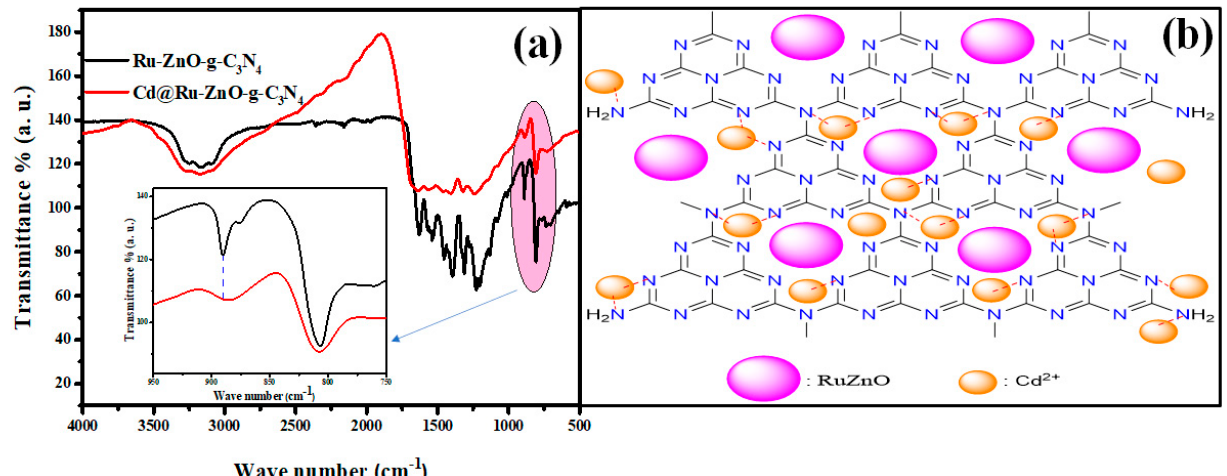
Figure 10. FTIR spectra of ( a ) before and after Cd ions into Ru-ZnO-g-C 3 N 4 and ( b ) suggested removal mechanism. Table 3. Monitoring characteristics for the adsorption of Cd ions onto the Ru-ZnO-g-C 3 N 4 nanocom- posites in comparison to other adsorbents and